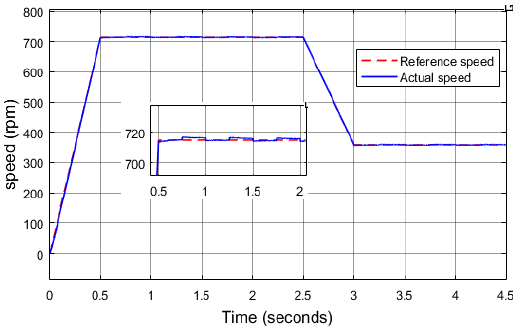
Fig. 10. Pulse load torque: amplitude 3 (N.m), period 0.5 s, pulse width 50%. The simulation results depicted in Fig. 11 and Fig. 12 demonstrate clearly that the proposed method based hysteresis current technique without current sensors is effective in controlling the IM drives. The speed of IMs can be maintained stably even with the load torque varying continuously periodic.